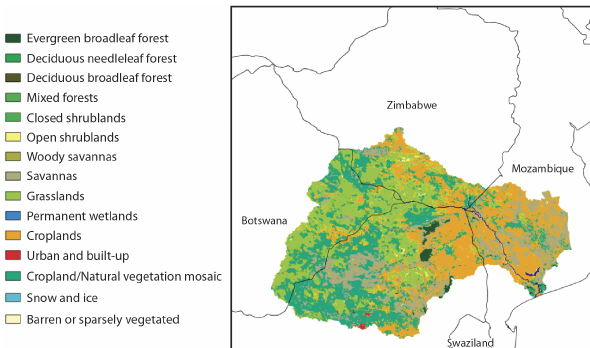
Figure 1. Land use in the Limpopo River basin (source: IGBP; Loveland et al., 2000). The orange coloured regions are classified as croplands, most of which are rain-fed.